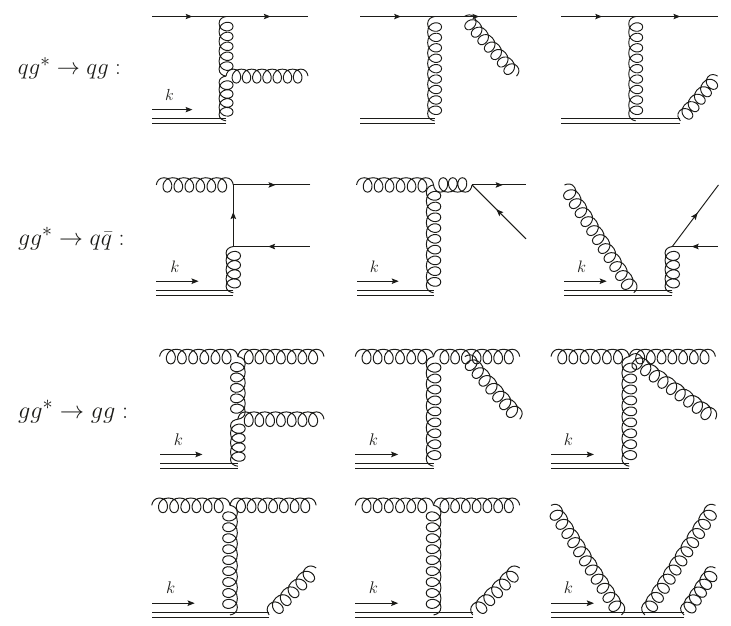
( i ) for various channels. ag ∗ → bc H i/ ( p P + iǫ ). These diagrams − ·